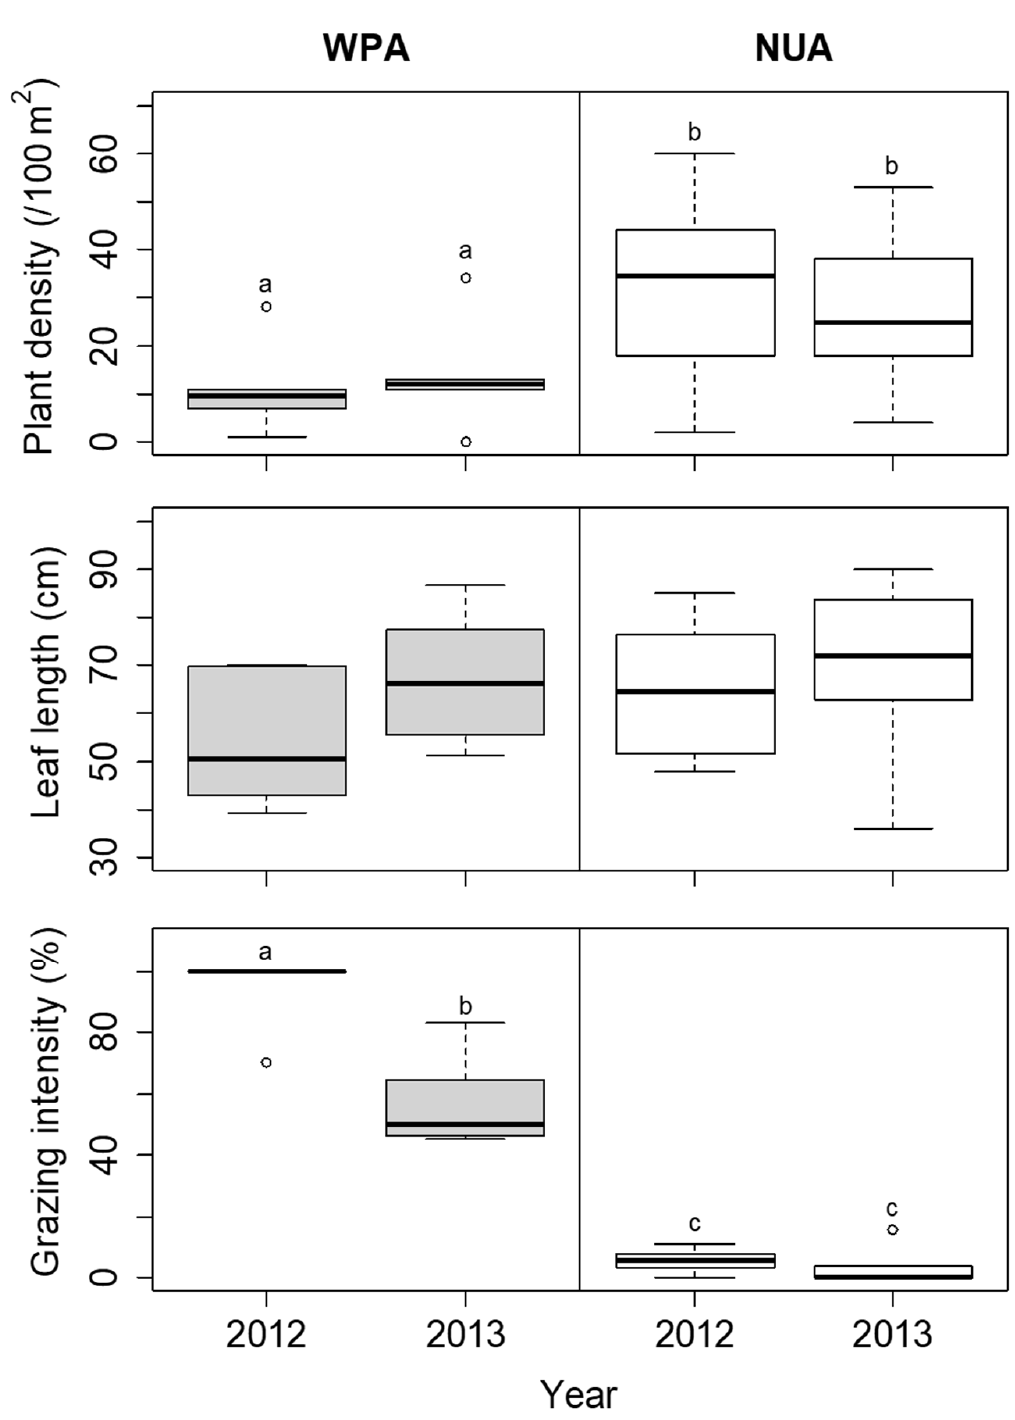
Figure 7. Comparison of plant density, leaf length, and grazing intensity of Dryopteris crassirhizoma between the wildlife protected area (WPA) and the neighboring unprotected area (NUA) from 2012 to 2013. Deer hunting was banned at WPA until the 2012 survey, but the ban was lifted before the 2013 survey. The boxplots indicate the first quartile, median, and third quartile. Different letters indicate significant difference between sites in each year ( α = 0.05).